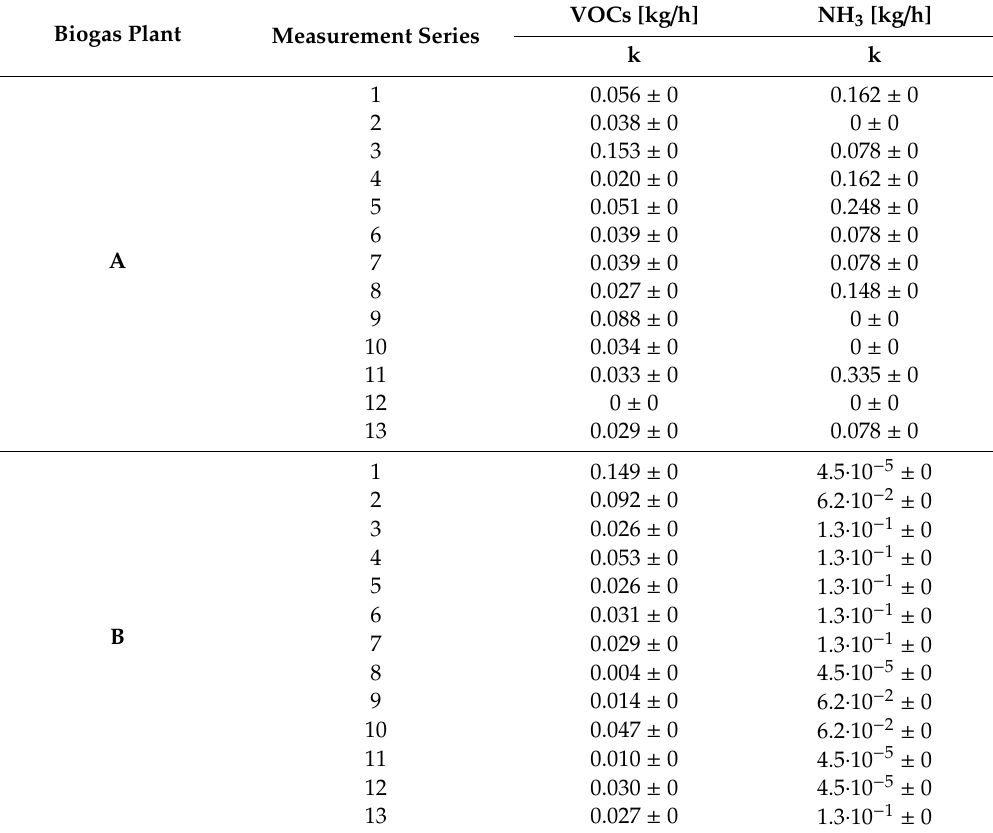
Table 10. Measurement results of the emissions from